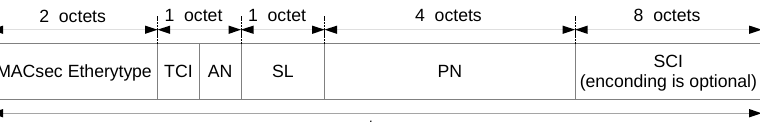
Figure 5. Security tag